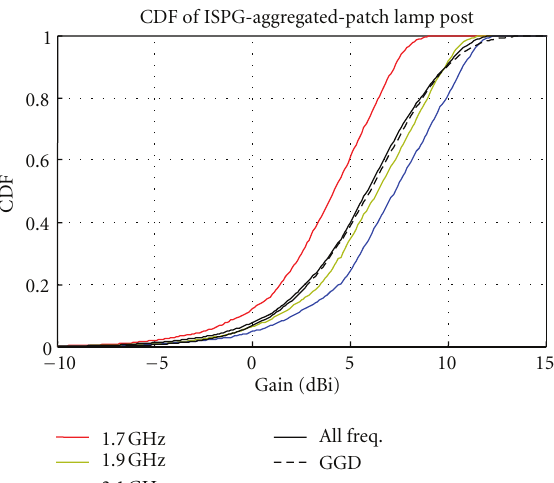
Figure 25: ISPG distribution for patch-lamppost scenario and fitted Gaussian distribution.